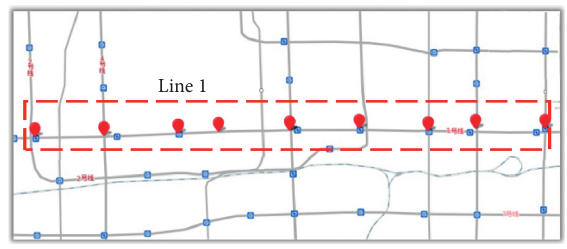
Figure 11: Anomalies on Line 1 at 5:00 on August 23,